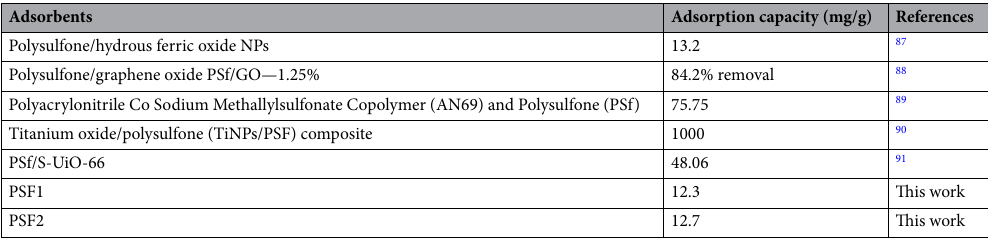
Table 4. The maximum adsorption capacities of PSF and other adsorbents for